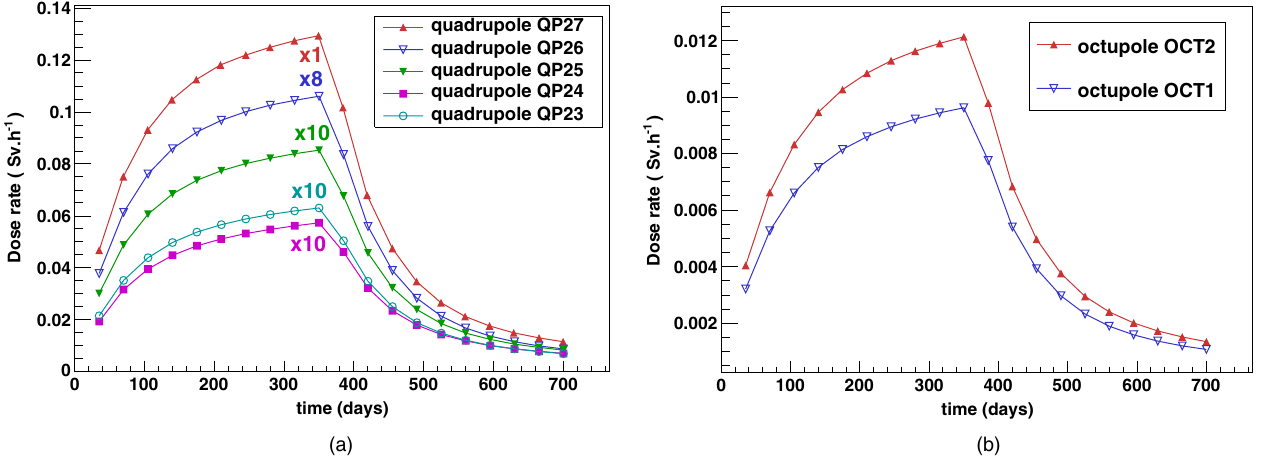
FIG. 12. Dose rates calculated at 1 m from the element surface for the HEBT-S3 magnets: (a) quadrupoles and (b) octupoles.